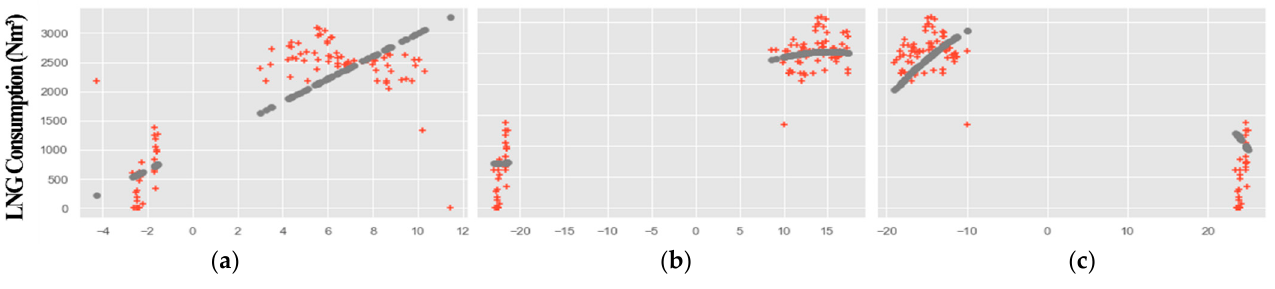
Figure 13. Scatterplot of the SVR (linear, RBF, polynomial kernels)-based LNG Usage Prediction Model: ( a ) SVR-linear, ( b ) SVR-RBF, and ( c ) SVR-polynomial. The red “+” marks represent the distribution of the measurement data, and the gray line indicates the regression line.